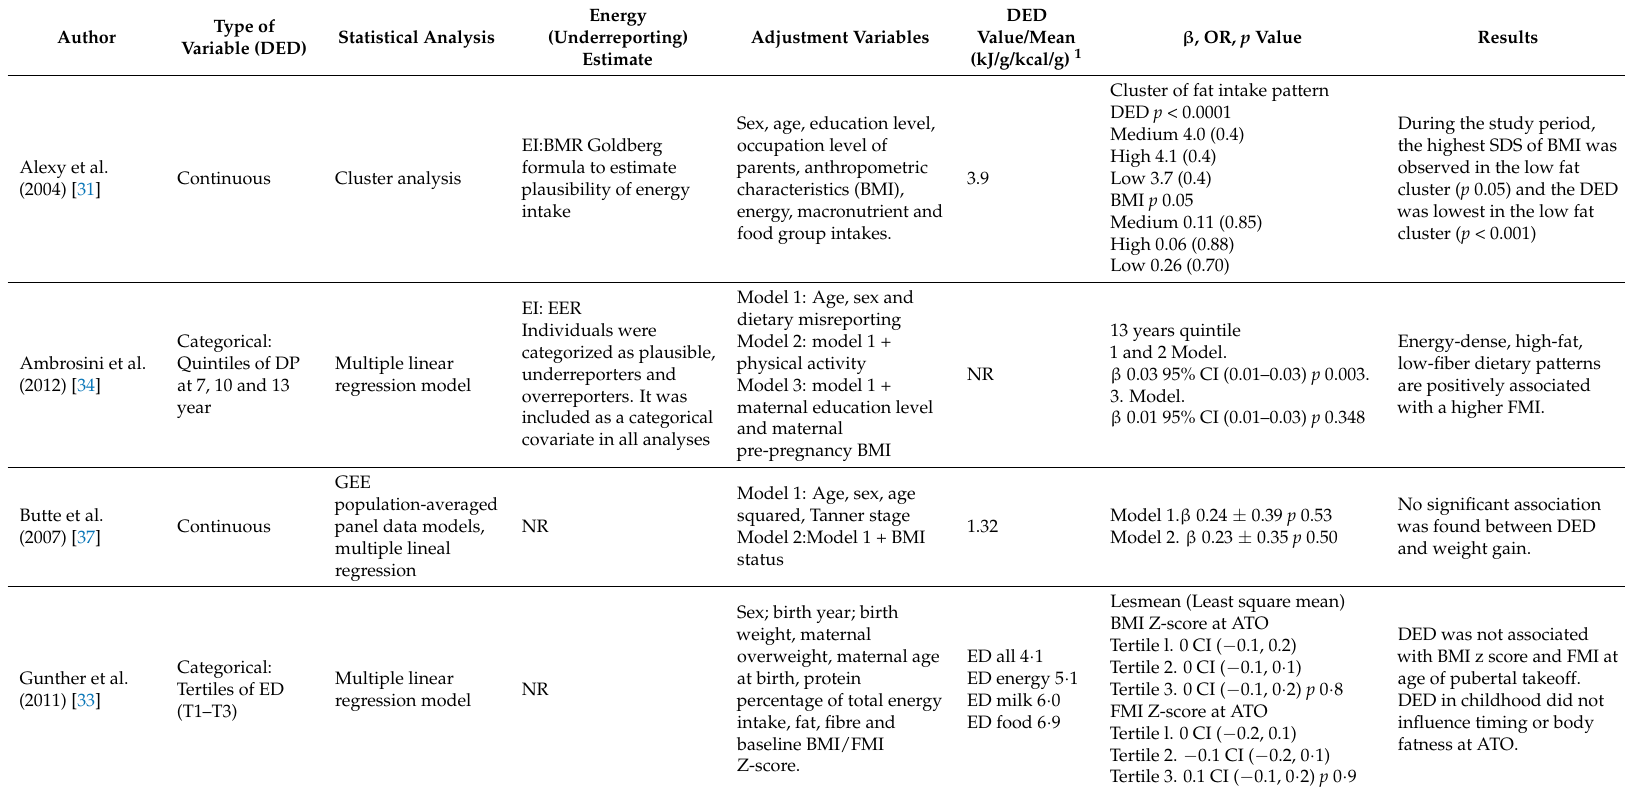
Table 2. Characteristics and results of the eligible studies